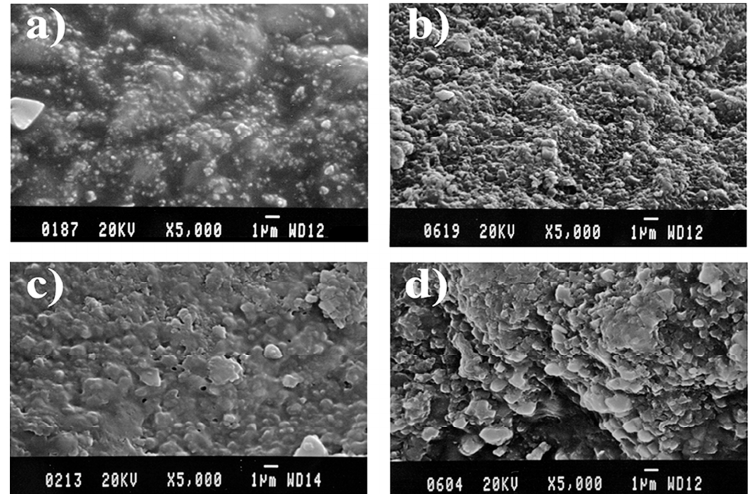
Figure 11. SEM micrographs showing the development in clear bands: ( a ) Rio Grande do Sul, Brazil 135 Ma, (52 nm) 135 Ma; ( b ) Isle of Mull, Scotland, 60 Ma (72 nm); ( c ) Agate Creek, Queensland, Australia 275 Ma (74 nm); and ( d ) Ethiebeaton Quarry, Scotland 412 Ma (96 nm). The stated age is the host age and crystallite size is the mean crystallite size for that particular region. The properties of the Brazilian agate, including crystallite size, indicate a formation age of ~26 Ma. SEM details: small agate slices were coated with gold and examined in a JEOL 820 SEM. The experimental conditions used a 20 kV accelerating voltage with a current of 1 nA.